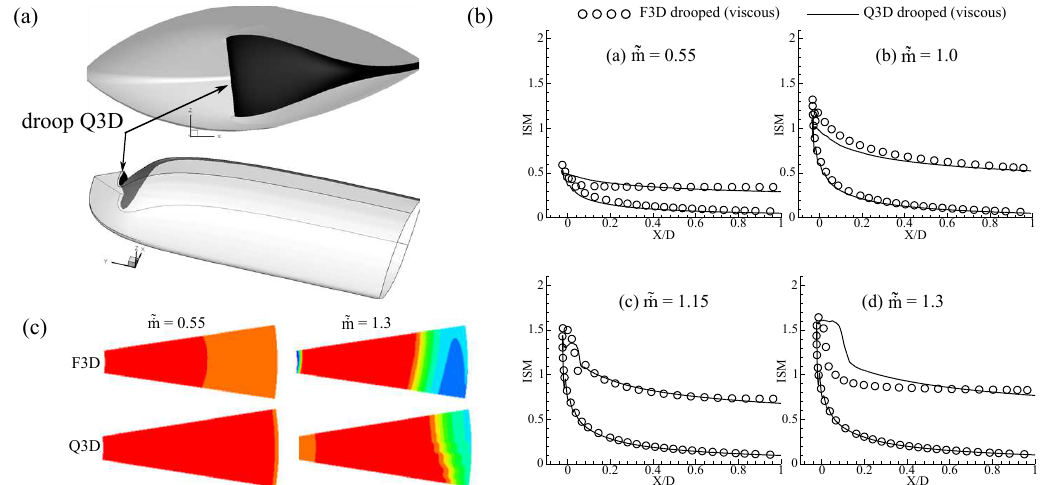
Figure A1. ( a ) Q3D drooped duct ( b ) ISM and ( c ) P 0 contours for F3D, Q3D drooped